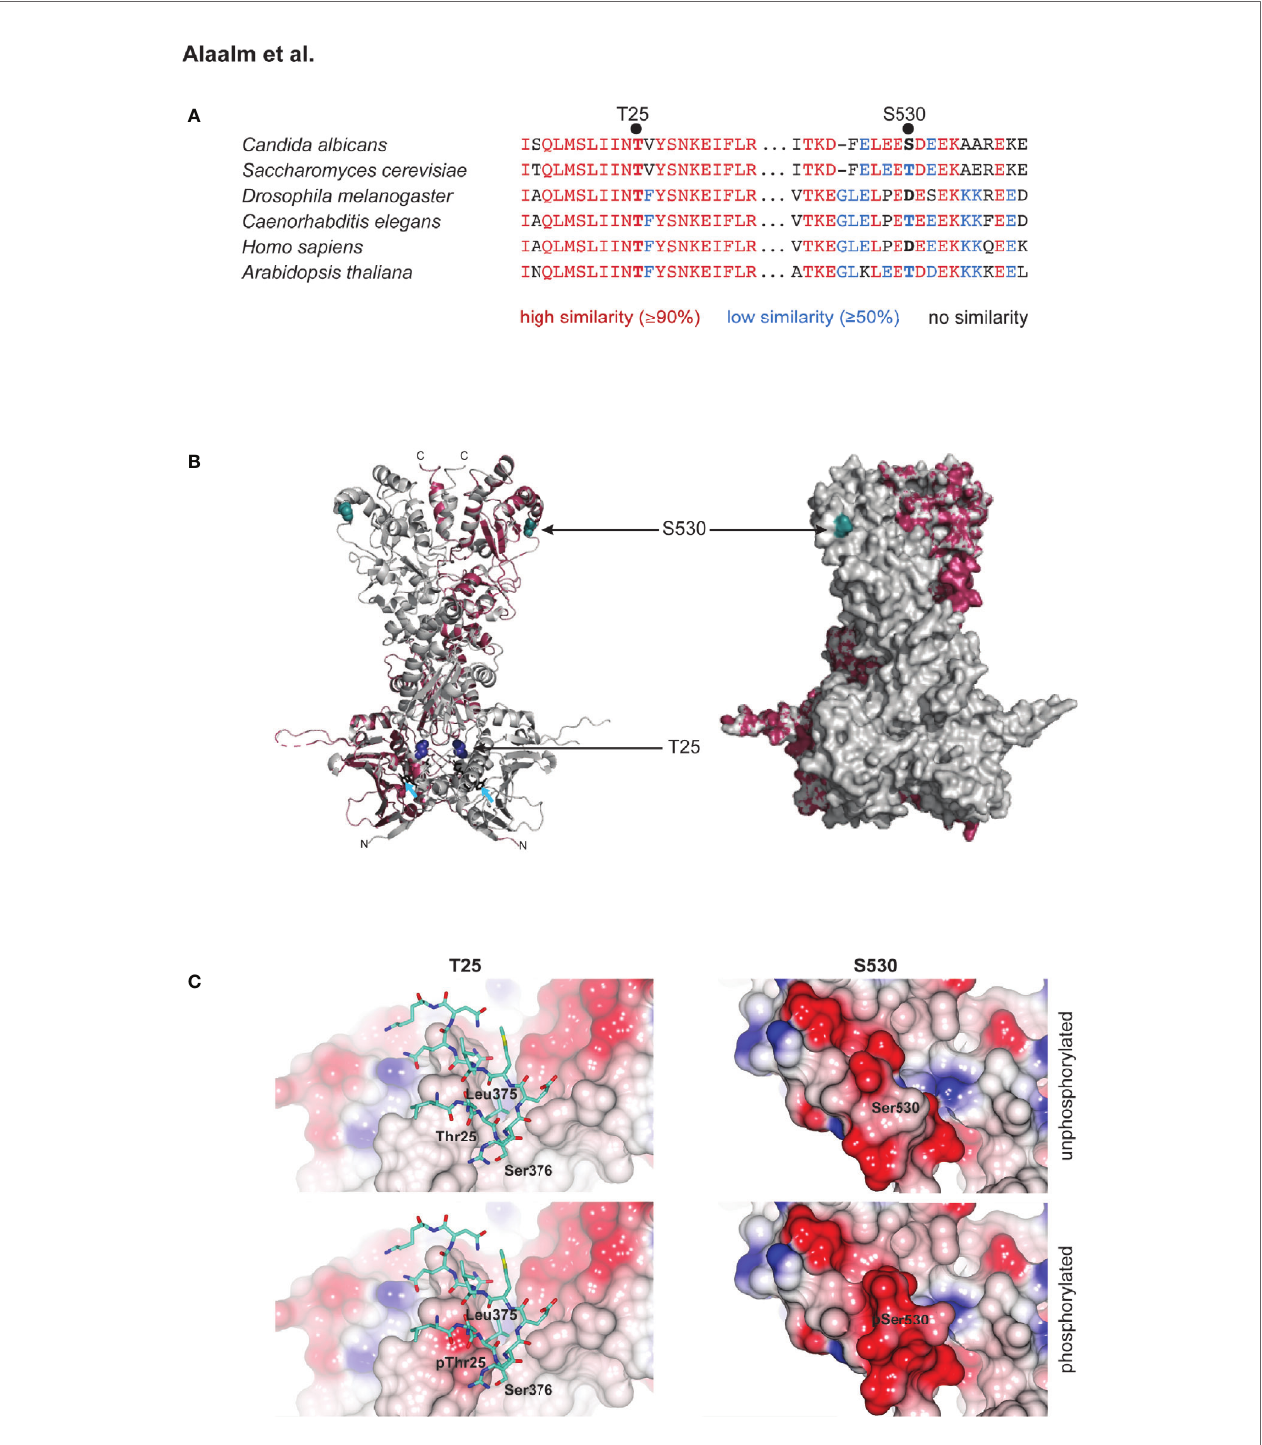
FIGURE 1 | Structural modeling of CK2 phosphorylation sites in Hsp90. (A) Alignment of eukaryotic Hsp90 protein sequences, comparing two fungal sequences to three animal and one plant protein. T25 resides in a highly conserved (red) region of the N-terminal domain of Hsp90. S530 is located in a divergent (blue) region of the Hsp90 C-terminus. (B) C . albicans Hsp90 (purple) modeled on the full-length crystal structure of S. cerevisiae Hsp90 (grey). T25 (blue) and S530 (teal) are visualized on the homology model (left) and the surface model (right). Azure arrows point to bound ATP in the homology model. (C) Electrostatic surfaces of Hsp90 in the vicinity of T25 (left) and S530 (right). Surface of one Hsp90 monomer is colored by electrostatic potential from -0.5 V (red) to +0.5 V (blue). In left hand panels, residues 373 – 384 of the second monomer of the Hsp90 dimer are rendered as sticks (carbon atoms cyan, other atom colors as standard). Upper panels, wild type Hsp90. Lower panels, Hsp90 with T25 or S530